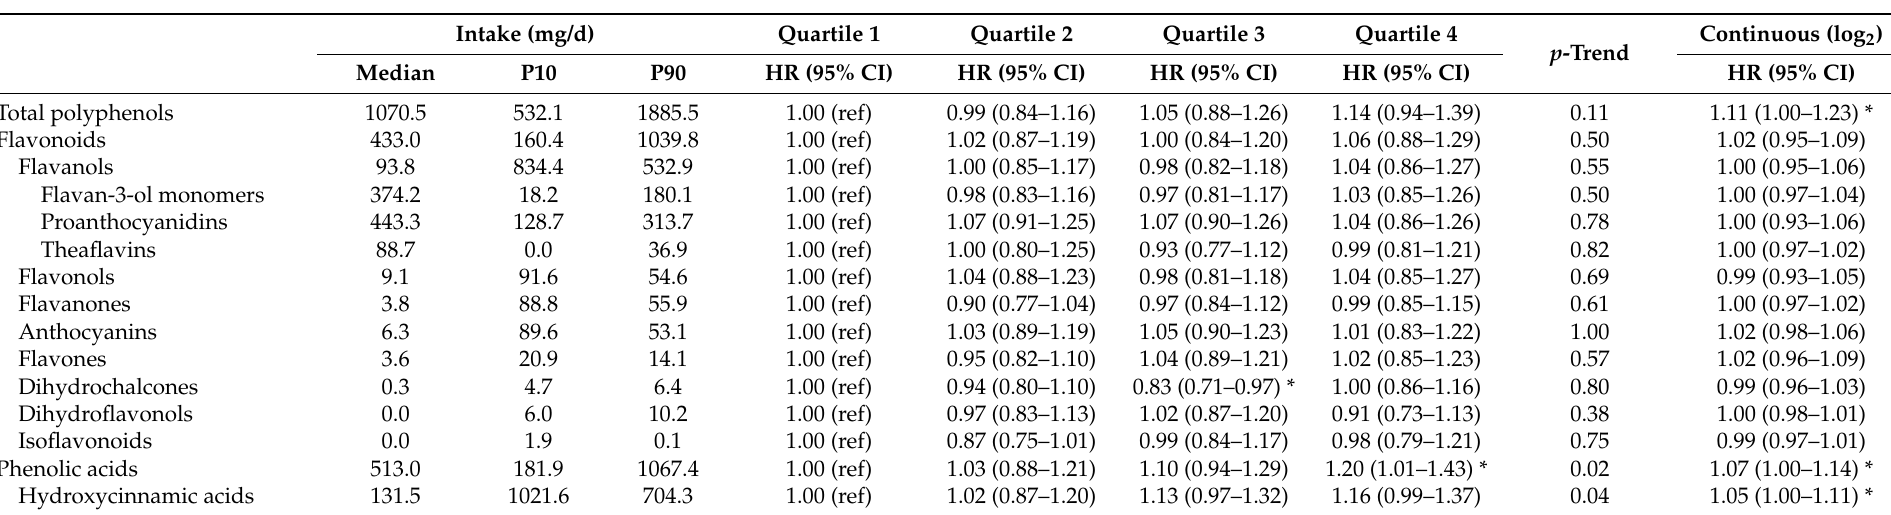
Table 2. Hazard ratios and 95% confidence intervals for epithelial ovarian cancer, according to quartile of intake of total, classes and subclasses of polyphenols in the EPIC